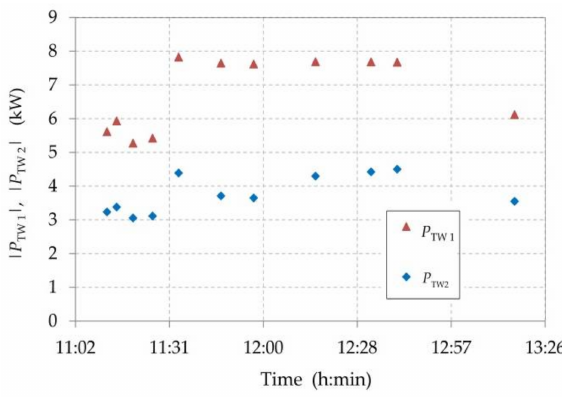
Figure 14. Calculated technical power ( P TW ) in Stages 1 and 2 of the gas mixture